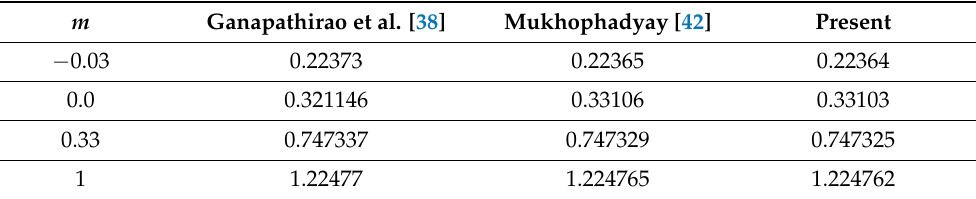
Table 2. Assessment of the coefficient of skin friction for numerous values of m when M = K = Rd = Ec = λ = γ = δ = 0 for Newtonian case.